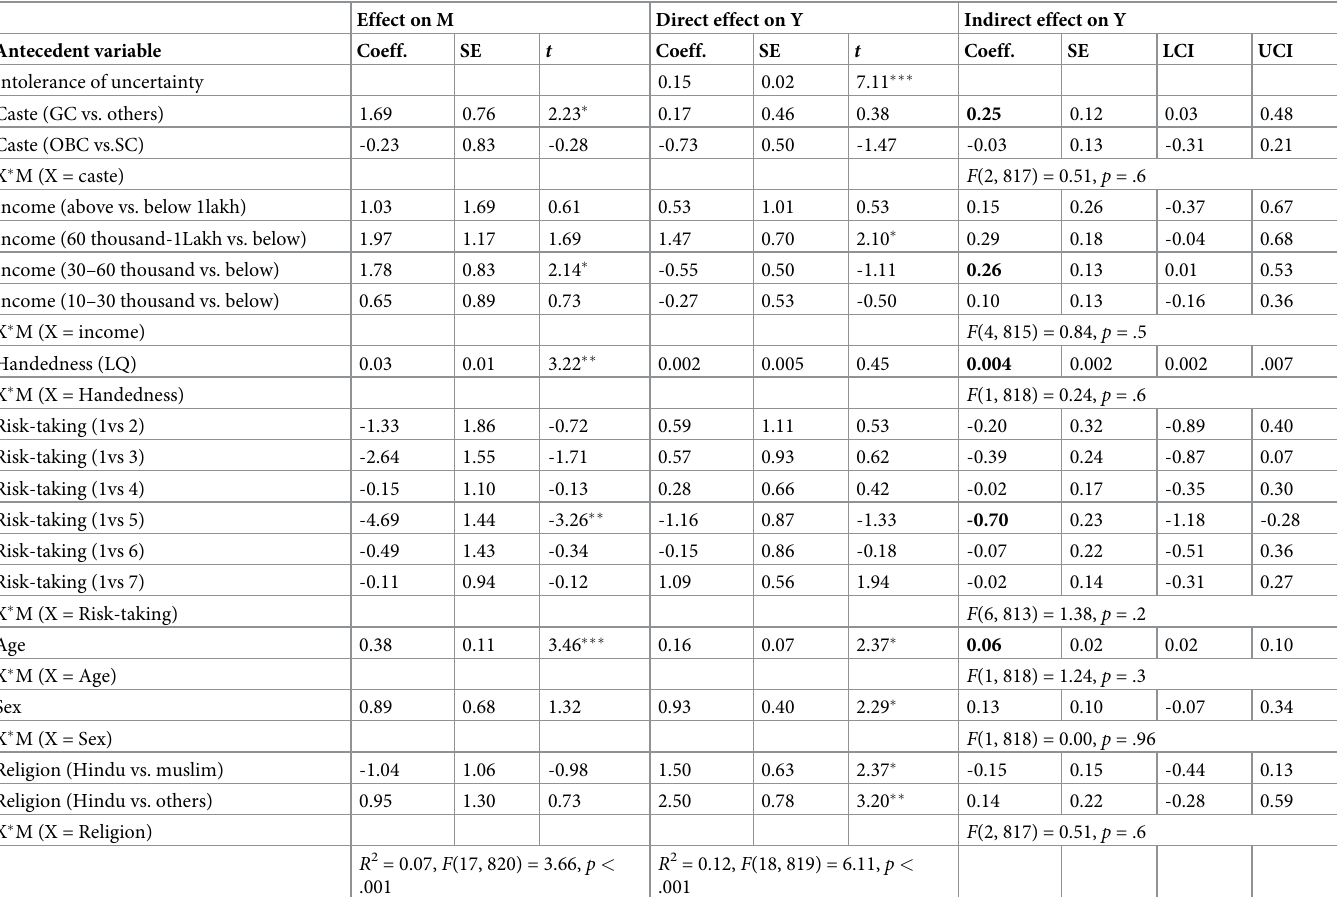
Table 7. The effects (direct and indirect effect) of antecedent and mediation (general IU) variables on belonging in the students’